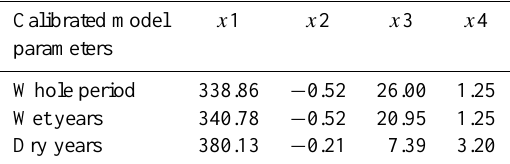
Table 3. Calibrated model